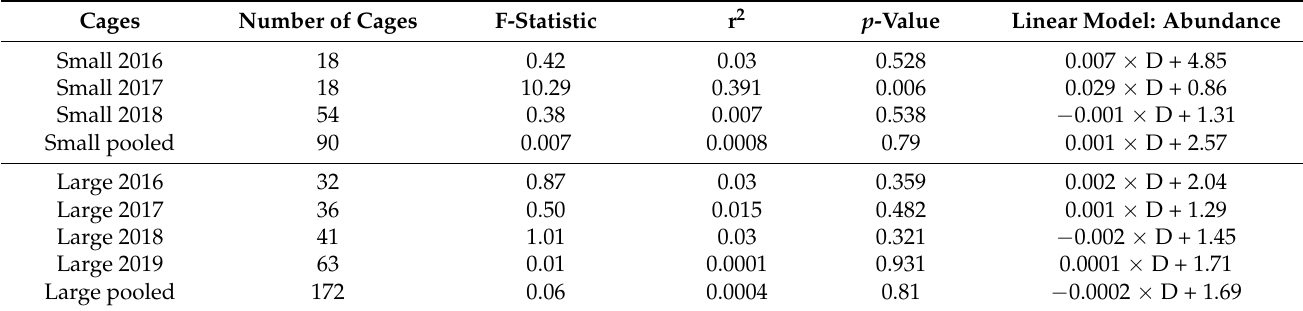
Figure 5. Number of decapods captured with small cages in 2016–2018. Black dashed line represents pooled regression line of all years. Single years are represented by dashed lines in colors according to years in the legend. Table 3. Results of the linear models with number of decapods per cage as a function of distance to the closest ecological foundation (=D) for the different combinations of cage type and